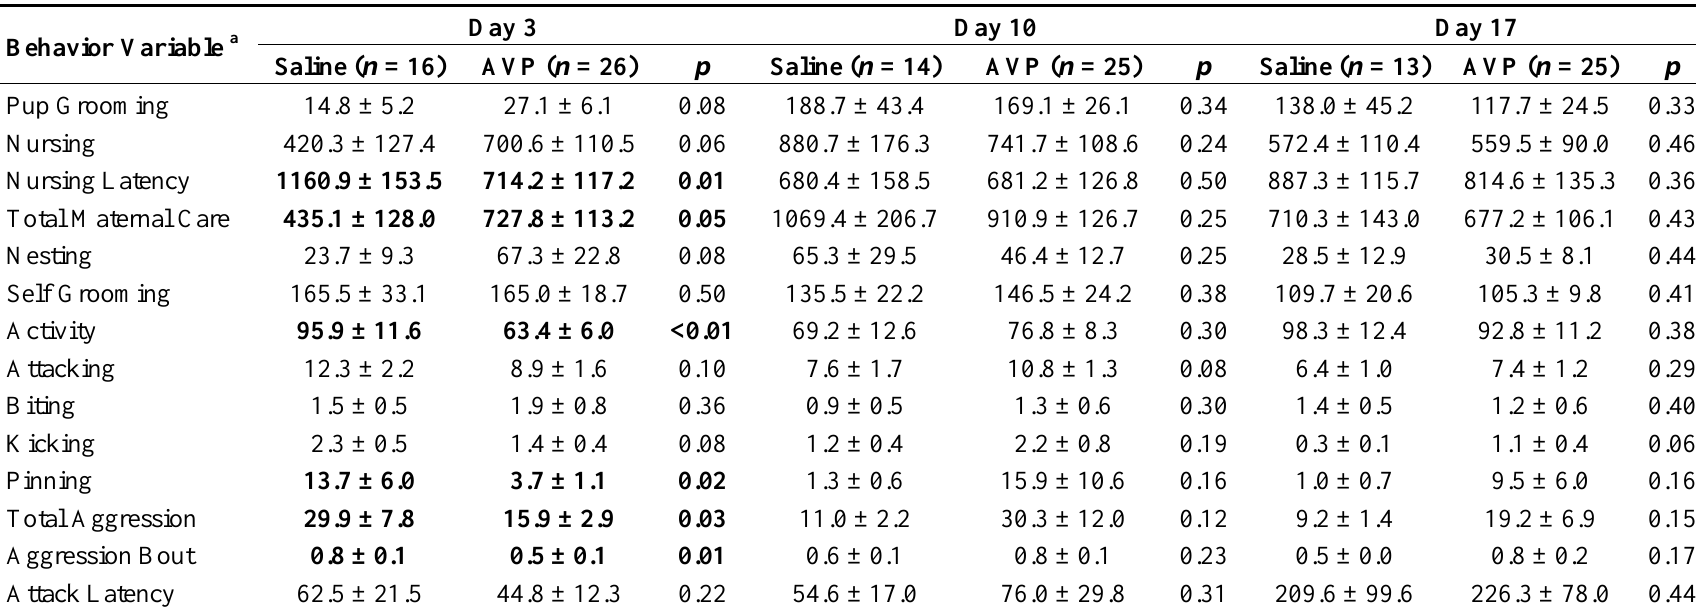
Table 2. Means ± SEM behavioral data during 30-min maternal aggression tests on lactation days 3, 10 and 17. Data in bold represent significant differences between saline and AVP treated